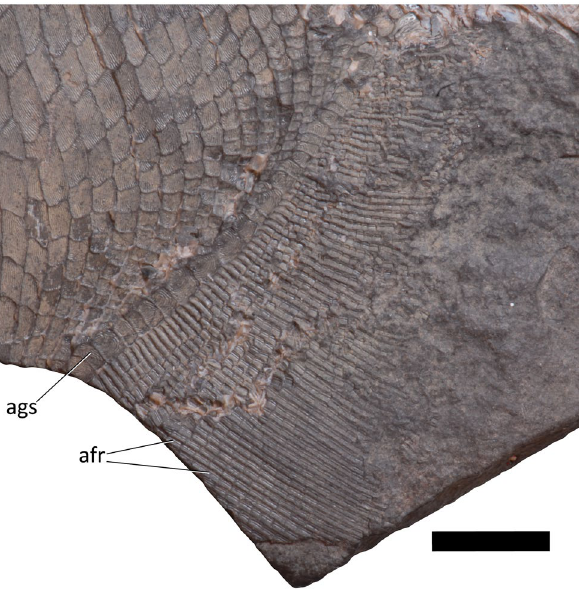
Figure 6. Detail of anal fin of platysomid specimen NSM 017.GF.017.001. Scale bar = 10 mm. afr, anal fin rays; ags, anal guard